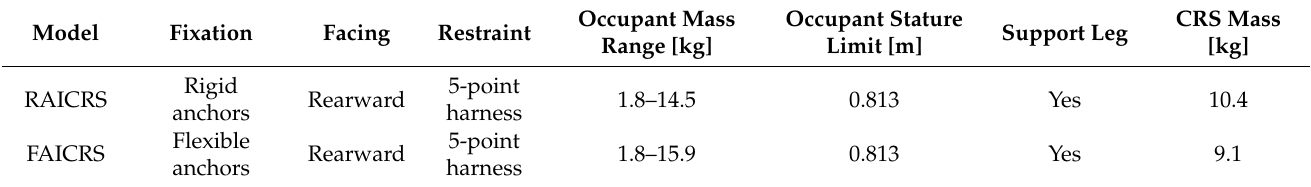
Table 1. Child restraint system models.